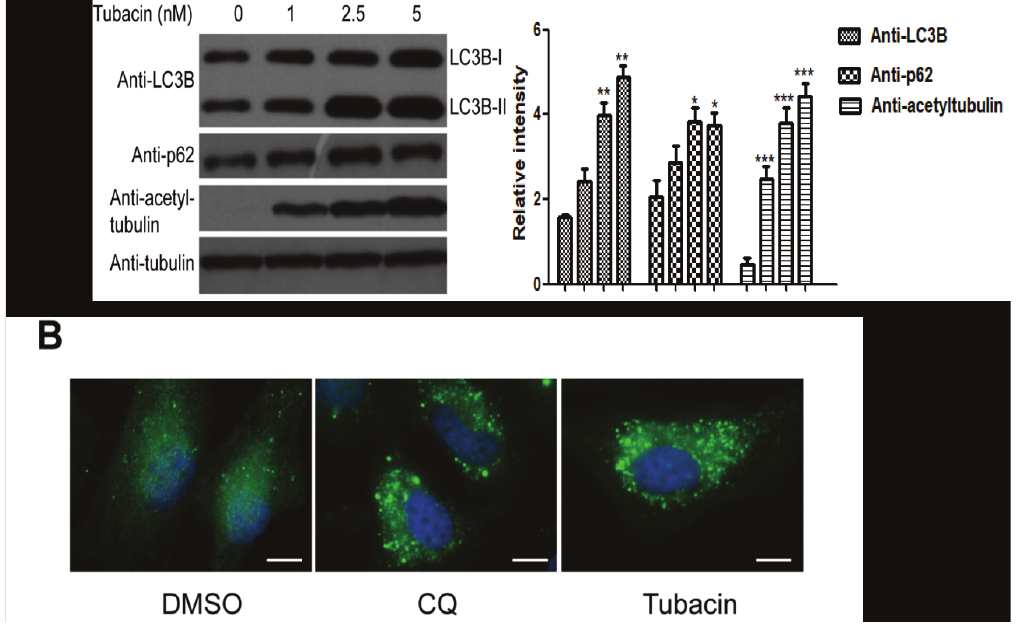
Figure 3: Inhibition of HDAC6 by tubacin suppressed autophagic degradation. (a) U251 cells were treated with the indicated concentration of tubacin. After 8 hours, cells were lysed and used for immunoblotting detection with antibodies. (b) U251 cells were plated and treated with CQ (25μM) or tubacin (2nM) for 8 hours. Then cells were fixed and used to detect autophagic puncta by immunofluorescence with LC3B antibodies. Scale bars, 10 μM..The data shown was derived from 3 independent experiments.*P < 0.05, **P < 0.01 , ***P < 0.001 versus no tubacin